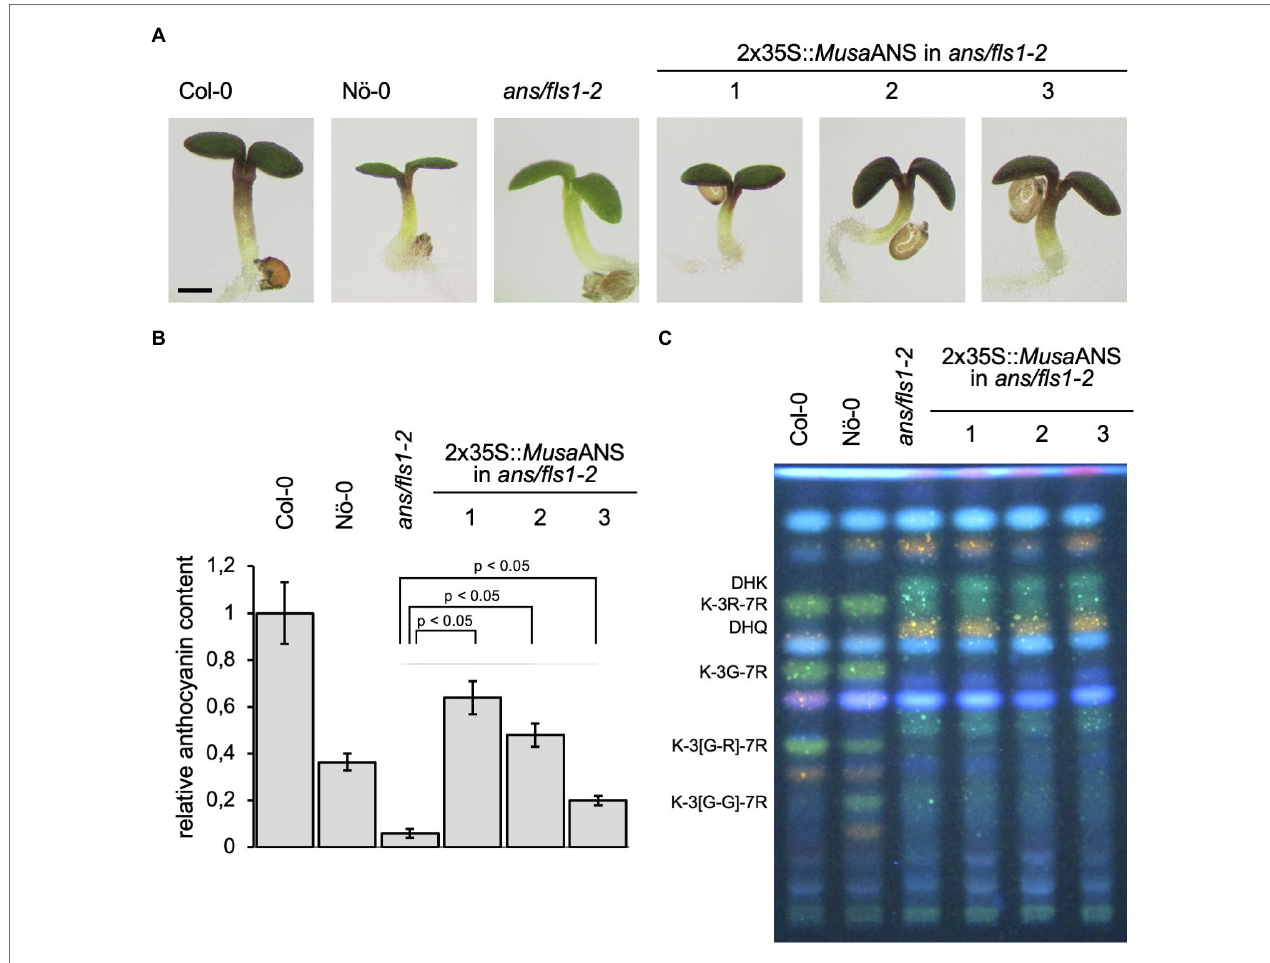
FIGURE 5 | Musa ANS is a functional anthocyanin synthase. Analysis of ans/fls1-2 double mutant seedlings complemented with 2x35S-driven MusaANS demonstrate in planta ANS functionality of Musa ANS by anthocyanin accumulation. The different numbers indicate individual transgenic lines. (A,B) Sucrose induced anthocyanin accumulation in 6-day-old Arabidopsis thaliana seedlings. (A) Representative pictures of seedlings (the scale bar indicates 0.5 mm) and (B) corresponding relative anthocyanin content. Error bars indicate the standard error for three independent measurements. (C) Musa ANS does not show in planta FLS activity. Flavonol glycoside accumulation in MusaANS -complemented ans/fls1-2 seedlings analysed by HPTLC analysis. Col-0, Nö-0 (both wild type) and ans/fls1-2 were used as controls. Bright green spots belong to derivatives of kaempferol, orange spots are derivatives of quercetin and faint blue shows sinapate derivatives. Dark green and yellow spots indicate DHK and DHQ, respectively. G, glucose; K, kaempferol; Q, quercetin; and R,